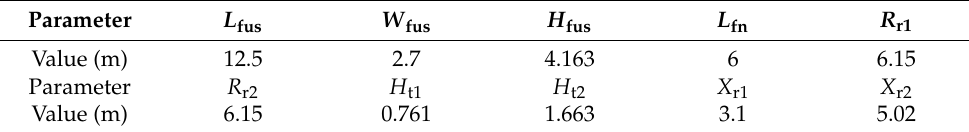
Figure 4. Model and size distribution of rotor 1.